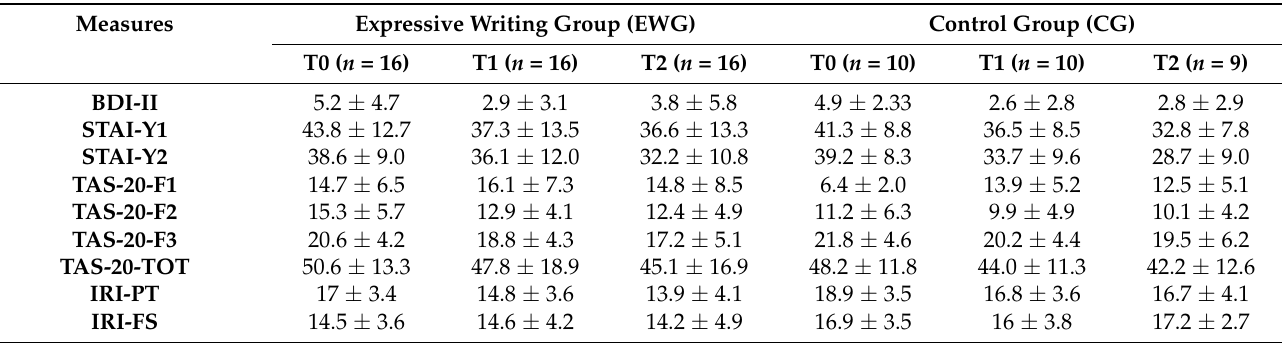
Figure 1. Consort 2010 Flow Diagram of the study. Table 2. Averages and standard deviations of psychological variables, adherence, biological variables, and health expenditure